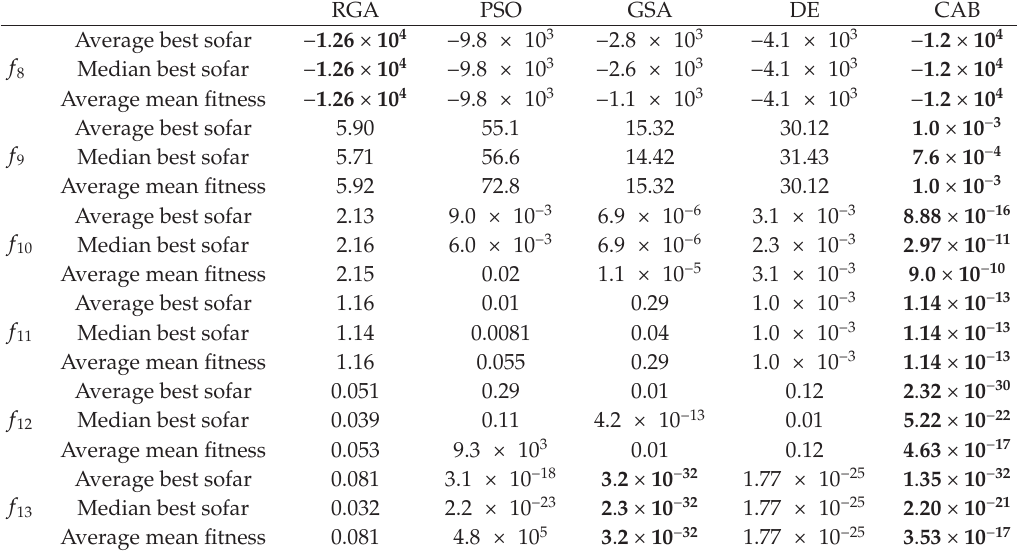
Table 5: Minimization of benchmark functions in Table 13 with n (cid:8) 30. Maximum number of iterations (cid:8) 1000.